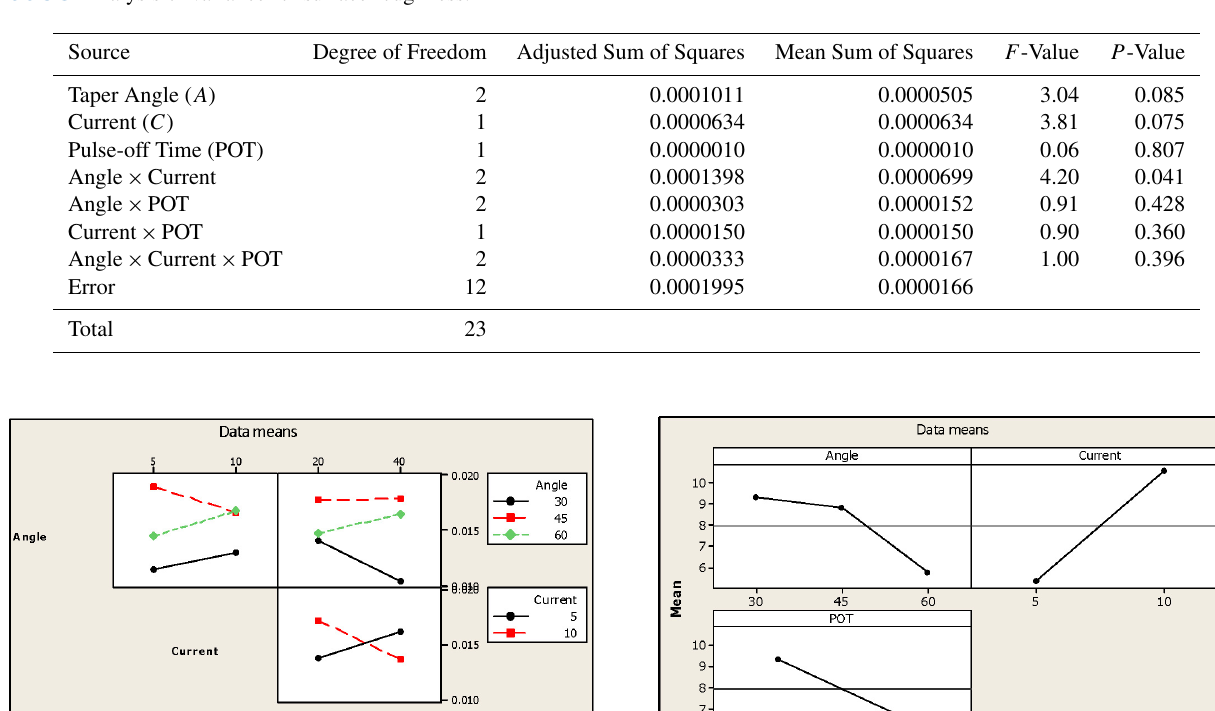
Table 5. Analysis of variance for surface roughness.